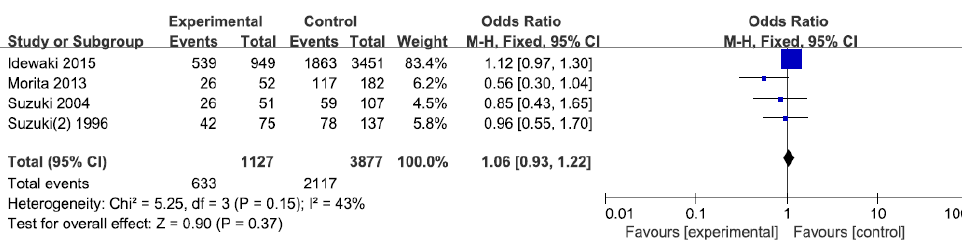
Figure 3. Forest plots of odds ratio for the association between ALDH2 rs671 and risks of DR.